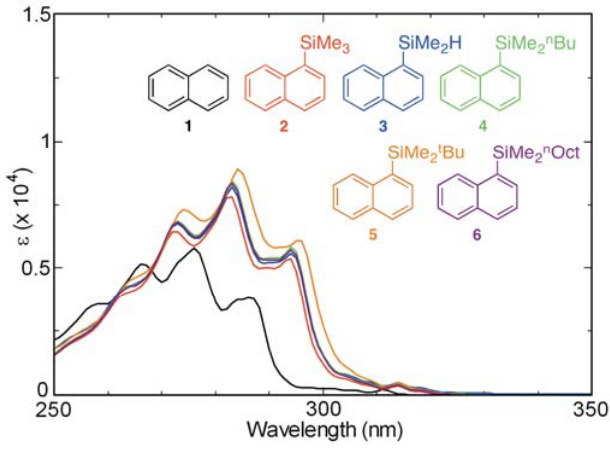
Figure 2. UV absorption spectra of 1–6 in cyclohexane (aerated, ca. 10 − 4